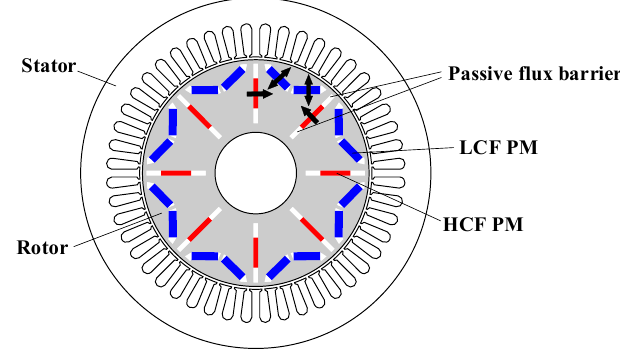
Figure 31. Quasi ‐ series hybrid PM VFM machine [82].